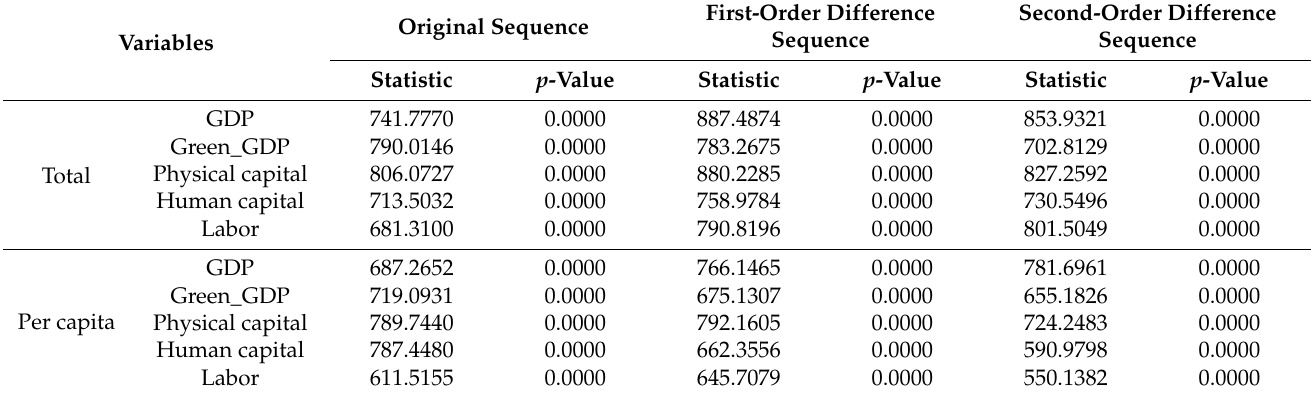
Table 2. Panel unit root test.